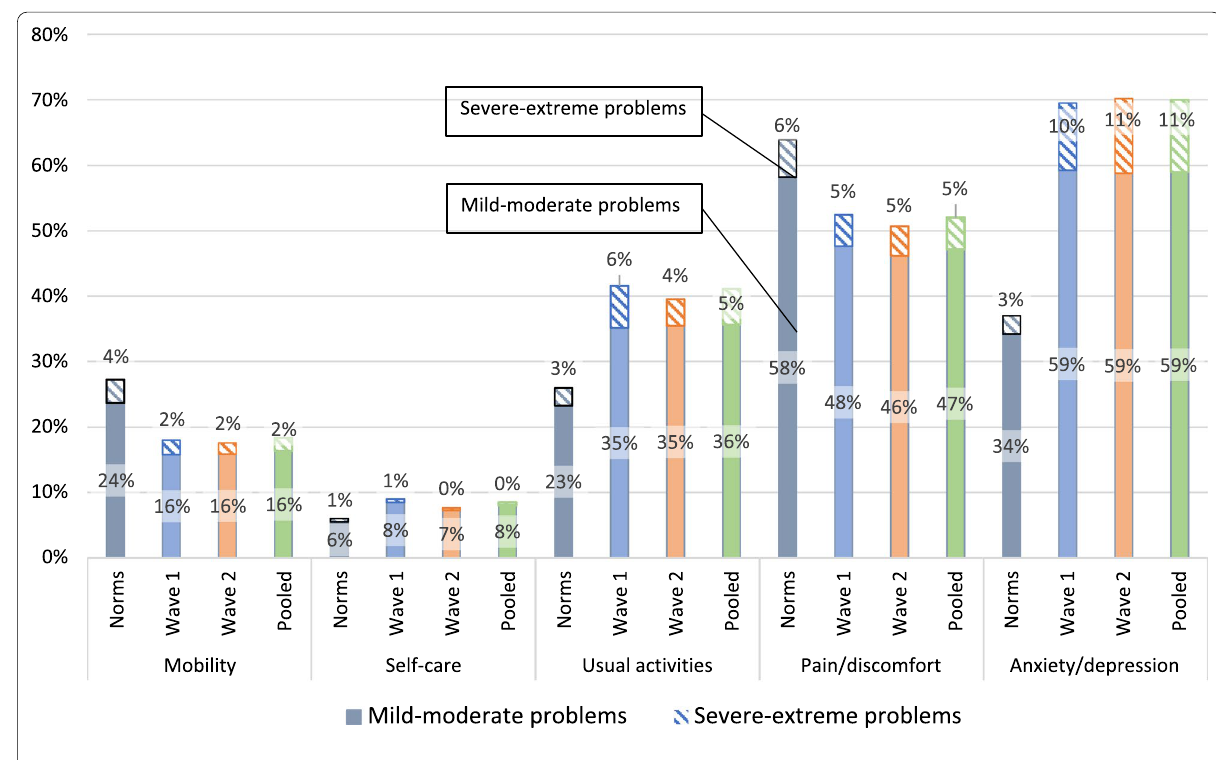
Fig. 2 Proportion of respondents reporting problems in each EQ-5D-5L dimension (the Alberta norm, survey 1, survey 2, and combined). Note : Between-wave differences: p < 0.001 in usual activities, p 0.019 in anxiety/depression dimension. Pooled data versus pre-pandemic norms: = p < 0.001 in all